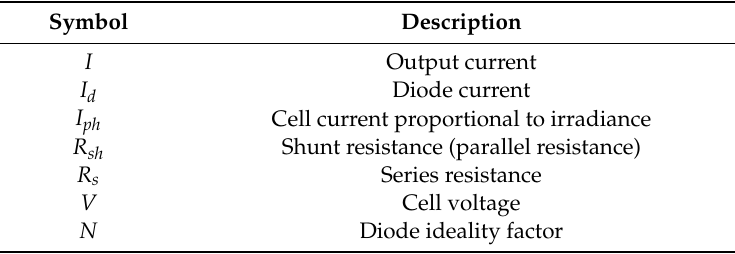
Table 2. Comparative study.